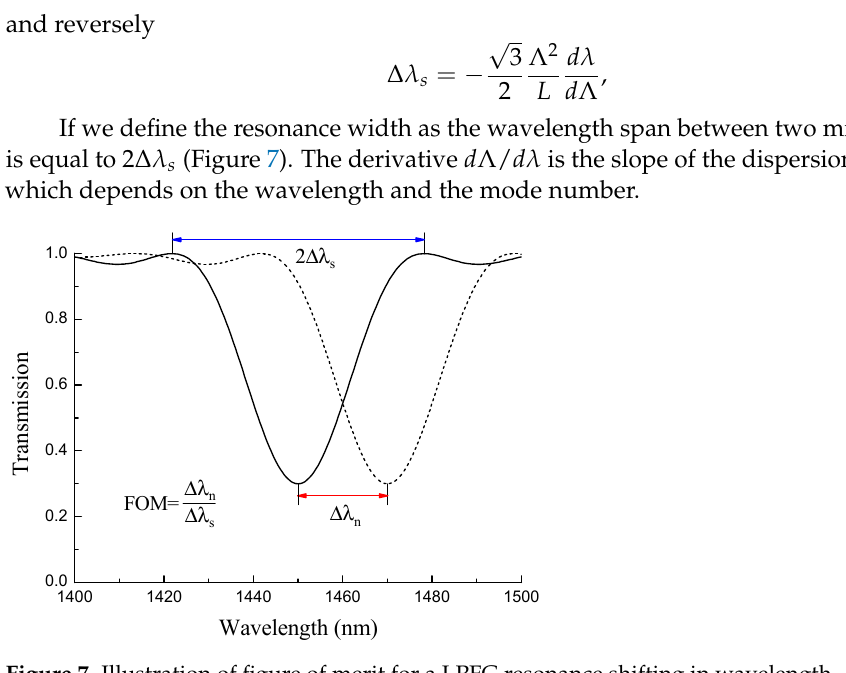
Figure 7. Illustration of figure of merit for a LPFG resonance shifting in wavelength.